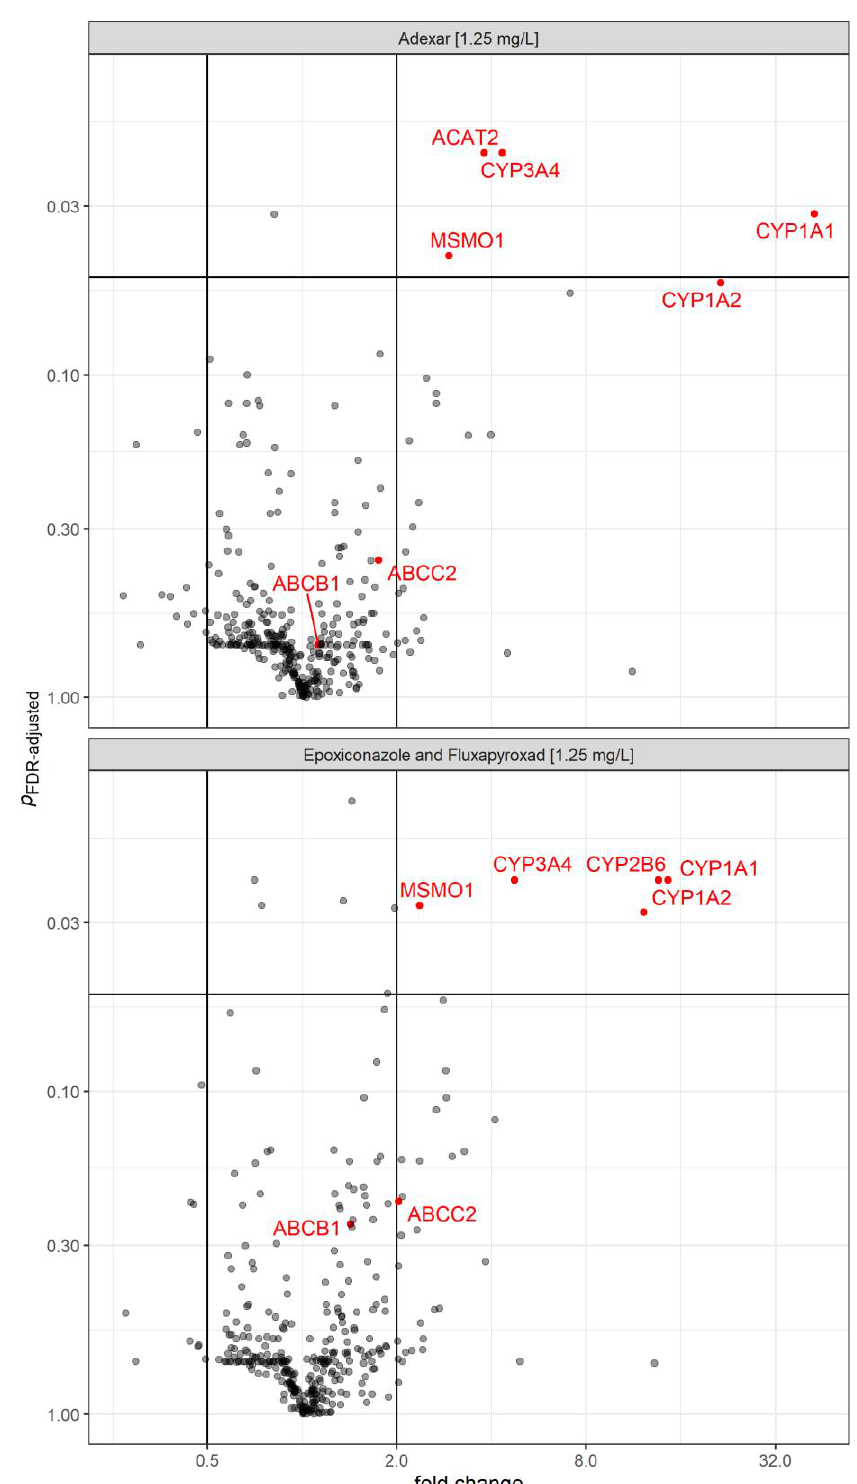
Figure 3: Gene expression changes (fold change) in HepaRG cells after 24 h treatment with Adexar® (1.25 mg/L (expressed as the active substances´ concentration within the product) in comparison to the solvent control and with the epoxiconazole and fluxapyroxad mix (1.25 mg/L each). Up and downregu- lation was considered relevant at <0.5 and >2-fold change in gene expression with significant gene transcripts indicated in red and labeled with gene symbols. P-values are adjusted by FDR-method (Ben- jamini and Hochberg, 1995). n=3 technical